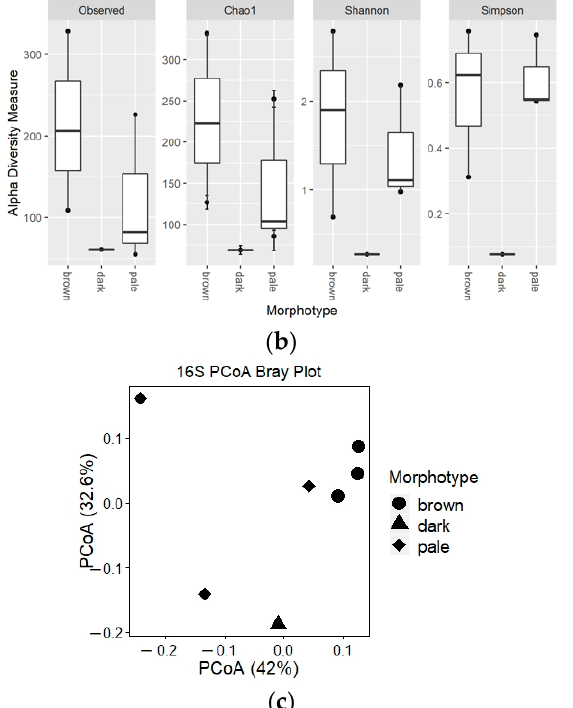
Figure 6. Estimated alpha diversity indices for ( a ) S. hansoni (brown morphotype). The diversity of panel ( a ) was estimated with sequence data from the V1–V2 region; ( b ) S. hansoni (brown morphotype), F. panamensis (dark morphotype), and Frankliniella (pale morphotype). Panel ( b ) diversity was estimated with sequence data from the V4–V5 region. ( c ) Structure of the bacterial community of thrips. ( a ) Principal Coordinate Analysis (PCoA) with the 16S rRNA gene. Nomenclature: LV, LV2 and LVn correspond to the La Vega farm, VFm and VFp correspond to the Villa Fátima farm, AASS1 and AASS2 to San Sebastian, BH1 to Barahonda, LS1 to Luisines, and EP1 to farm El Paraíso.